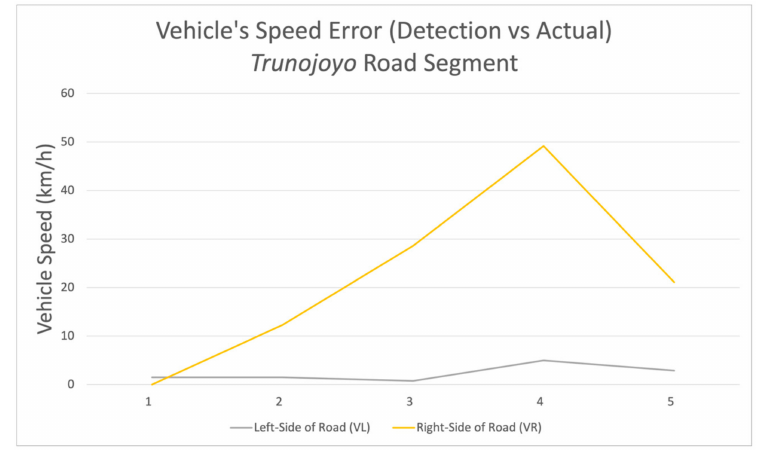
Figure 17. Error rate of vehicle speed calculation on Trunojoyo road segment. Merdeka-Aceh Intersection